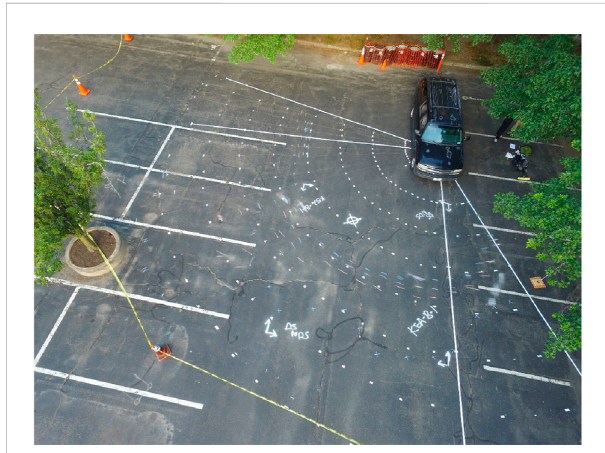
FIGURE 1 Drone imagery of the fi eld measurement area with four distinct lines of tape for the edges of the driver fi eld of view and the points directly in front and to the passenger side of the driver. Individual tape segments mark each fi ve-degree point at fi ve-foot increments from the